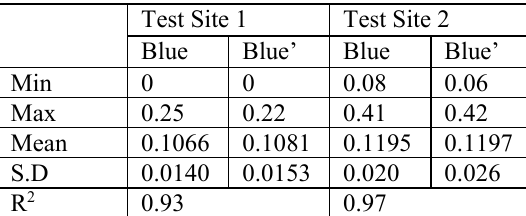
Table 2: Statistical results for the difference between blue channel and estimated blue channel Water body, vegetation and urban land use land cover classes in simulated NCC have high visual similarity to that of true color composite however, to eliminate the subjectivity in results statistical comparison were made by estimating the minimum, maximum, mean, median and correlation coefficient between original blue band and simulated blue band for both the areas. Table 2 shows the comparison of original and simulated blue band. In both test sites, correlation coefficient was found to be very high i.e. 0.93 and 0.97 for test site 1 and 2 respectively indicating